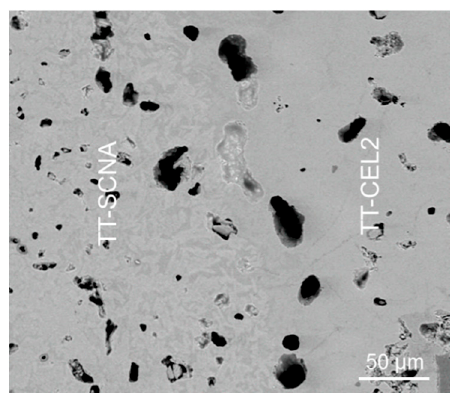
Figure 7. Bilayered glass-ceramic implant: interface between TT-CEL2 and TT-SCNA layers.